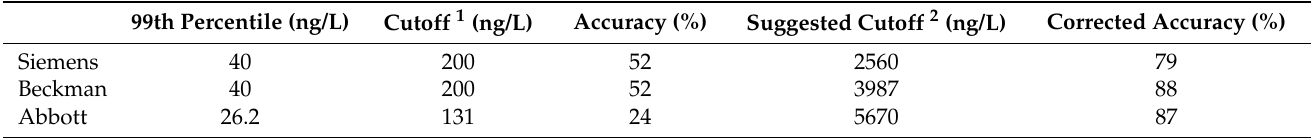
Table 6. Cutoff values and accuracy of the assays for MI type 4a.